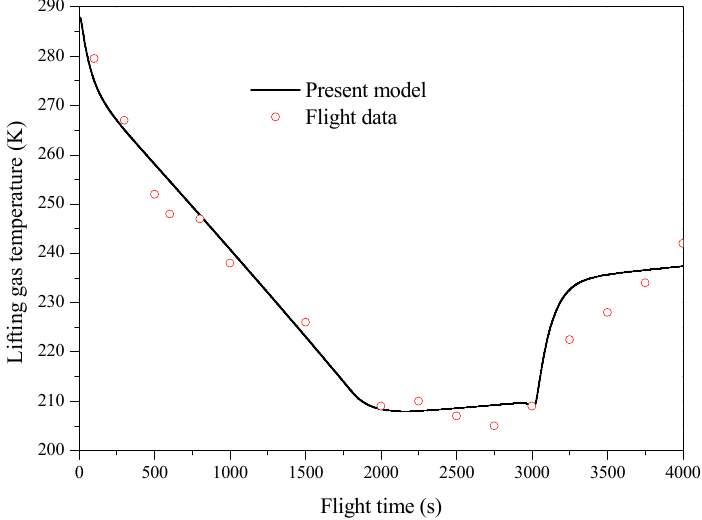
Figure 6. Comparison between the predicted data and the experimental data (lifting gas temperature).